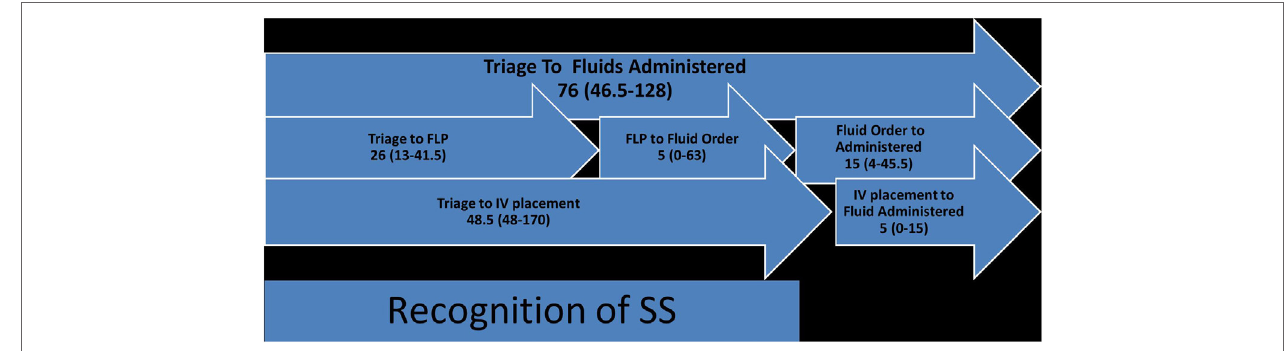
Figure 2 | Fluid and IV time course (FLP, front-line physician, usually ER-physician) (each numerical value in the figure represents time in minutes).